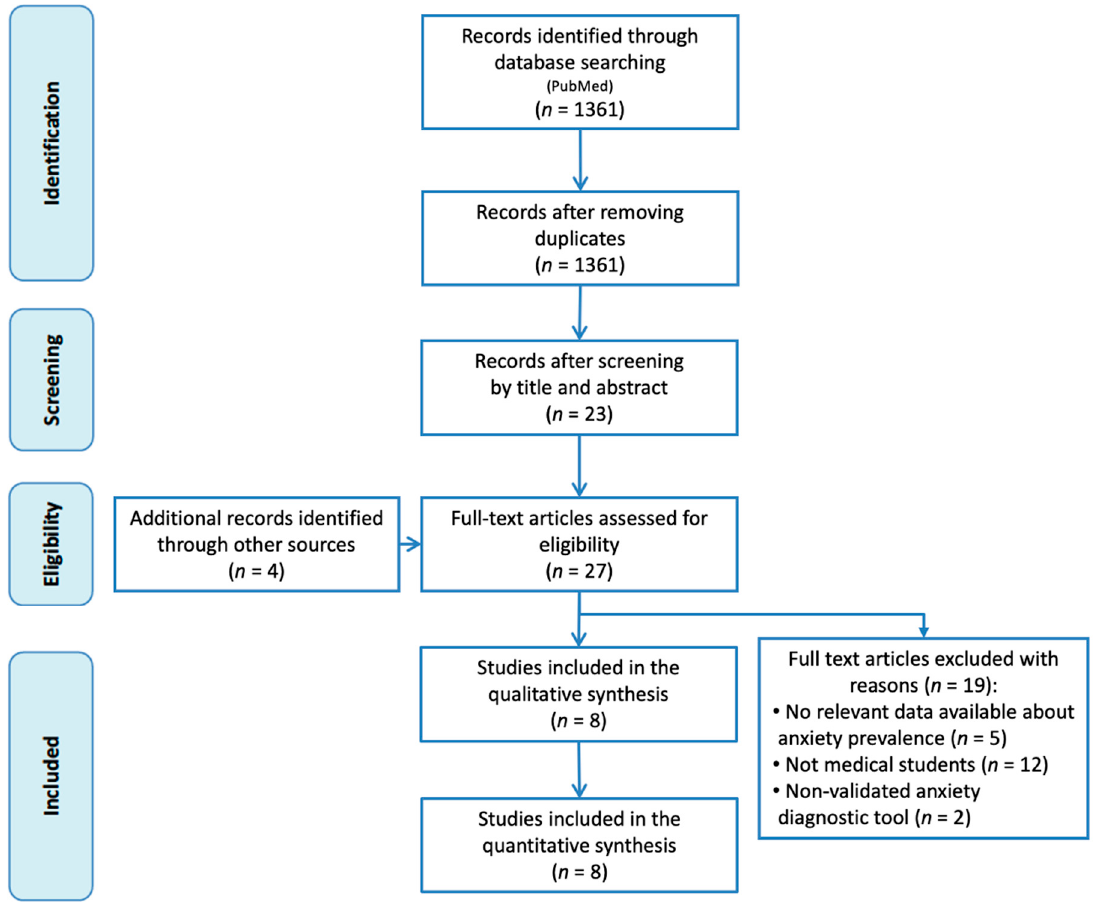
Figure 1. Flowchart of the study selection.